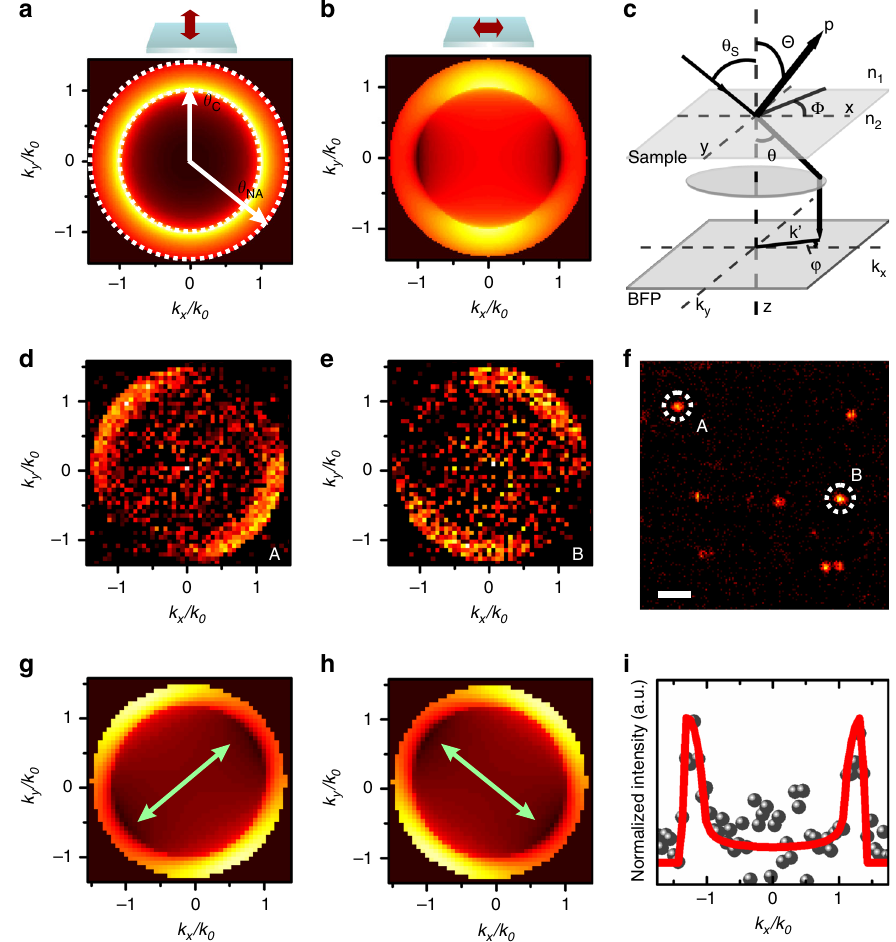
Fig. 2 k -vector resolved Fourier imaging of single CdSe quantum rings. a , b Calculated k -vector resolved emission pattern of a TDM lying vertically a and horizontally b on a sample plane. The critical angle ( θ C ) and the angle determined by the numerical aperture ( θ NA ) are indicated. c Schematic of angle- resolved photoluminescence spectroscopy on a Fourier imaging system. d , e Measured radiation patterns of QRs highlighted in f . f A scanning photoluminescence image used to locate single QRs. Scale bar: 2 µ m. g , h Calculated radiation patterns of QRs with their azimuthal angles adjusted to match those in d and e . i k -vector resolved emission pro fi les from experimentally measured (dots) and calculated (curve) radiation